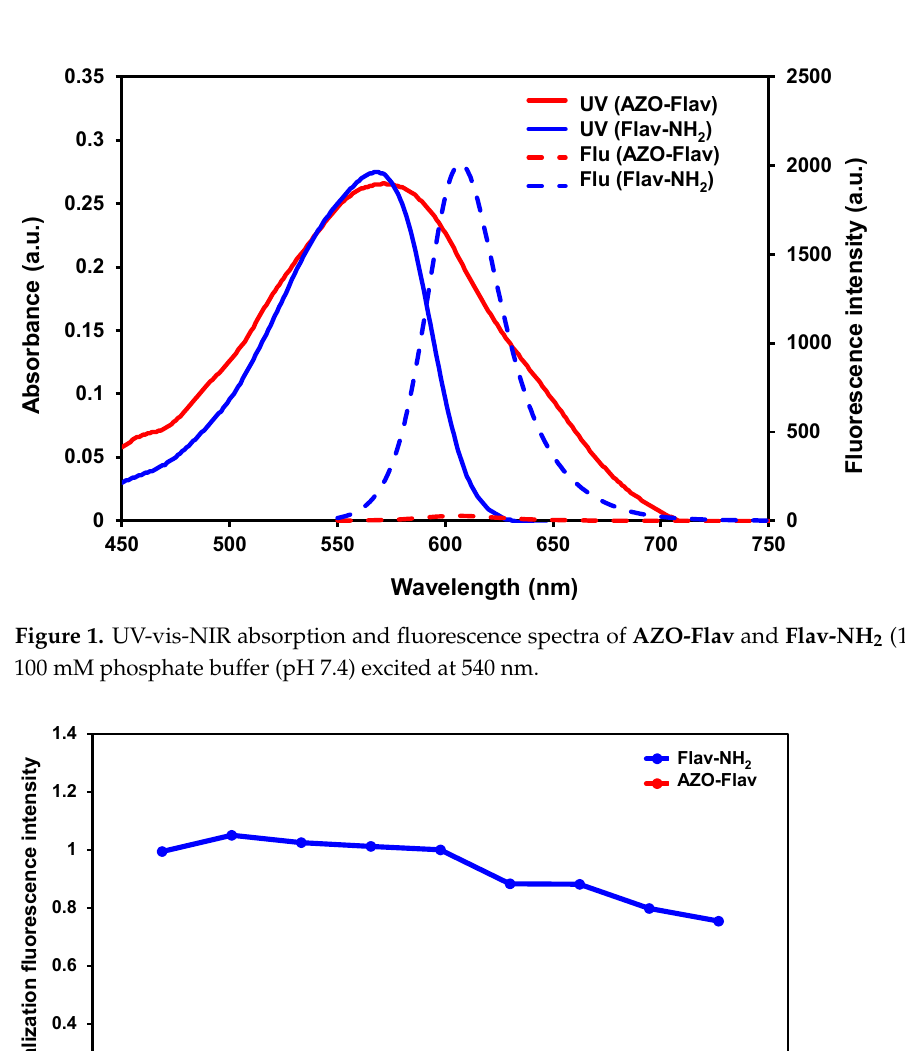
Figure 1. UV-vis-NIR absorption and fluorescence spectra of AZO-Flav and Flav-NH 2 (10 μ M) in 100 mM phosphate buffer (pH 7.4) excited at 540 nm.